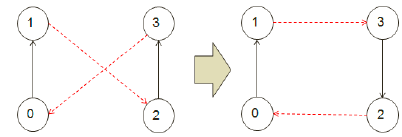
Figure 6. The 2-opt in-route swap